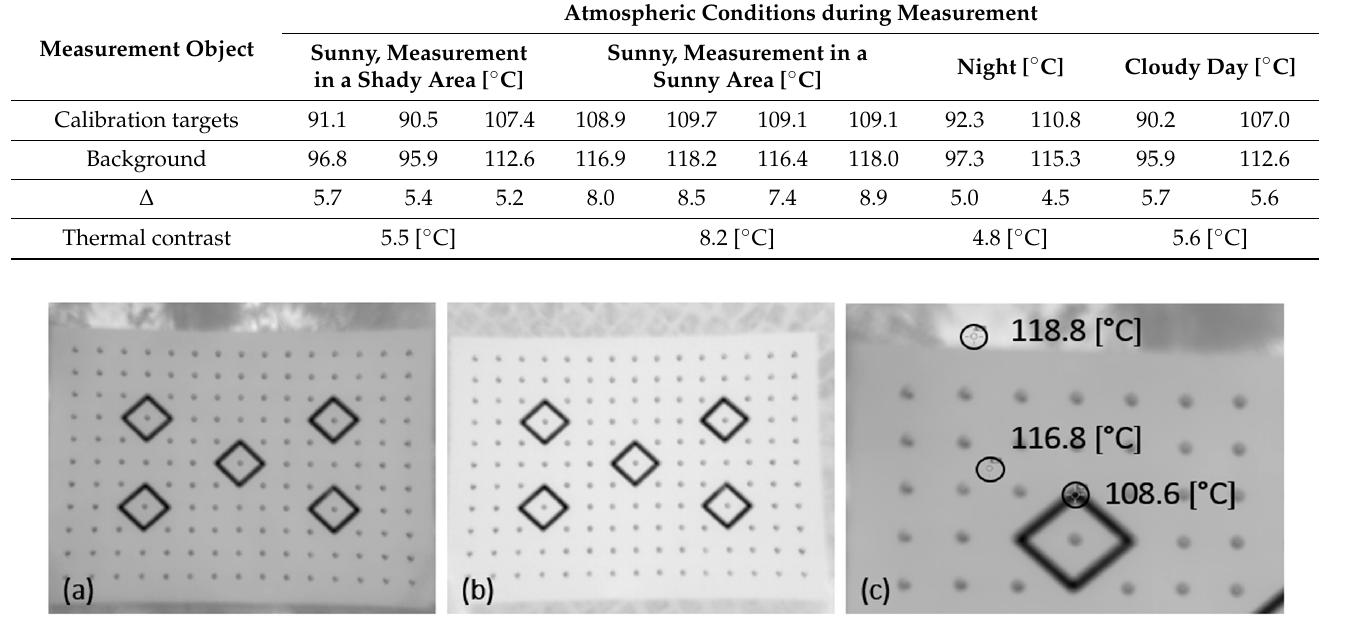
Table 7. Average values for Table A7.